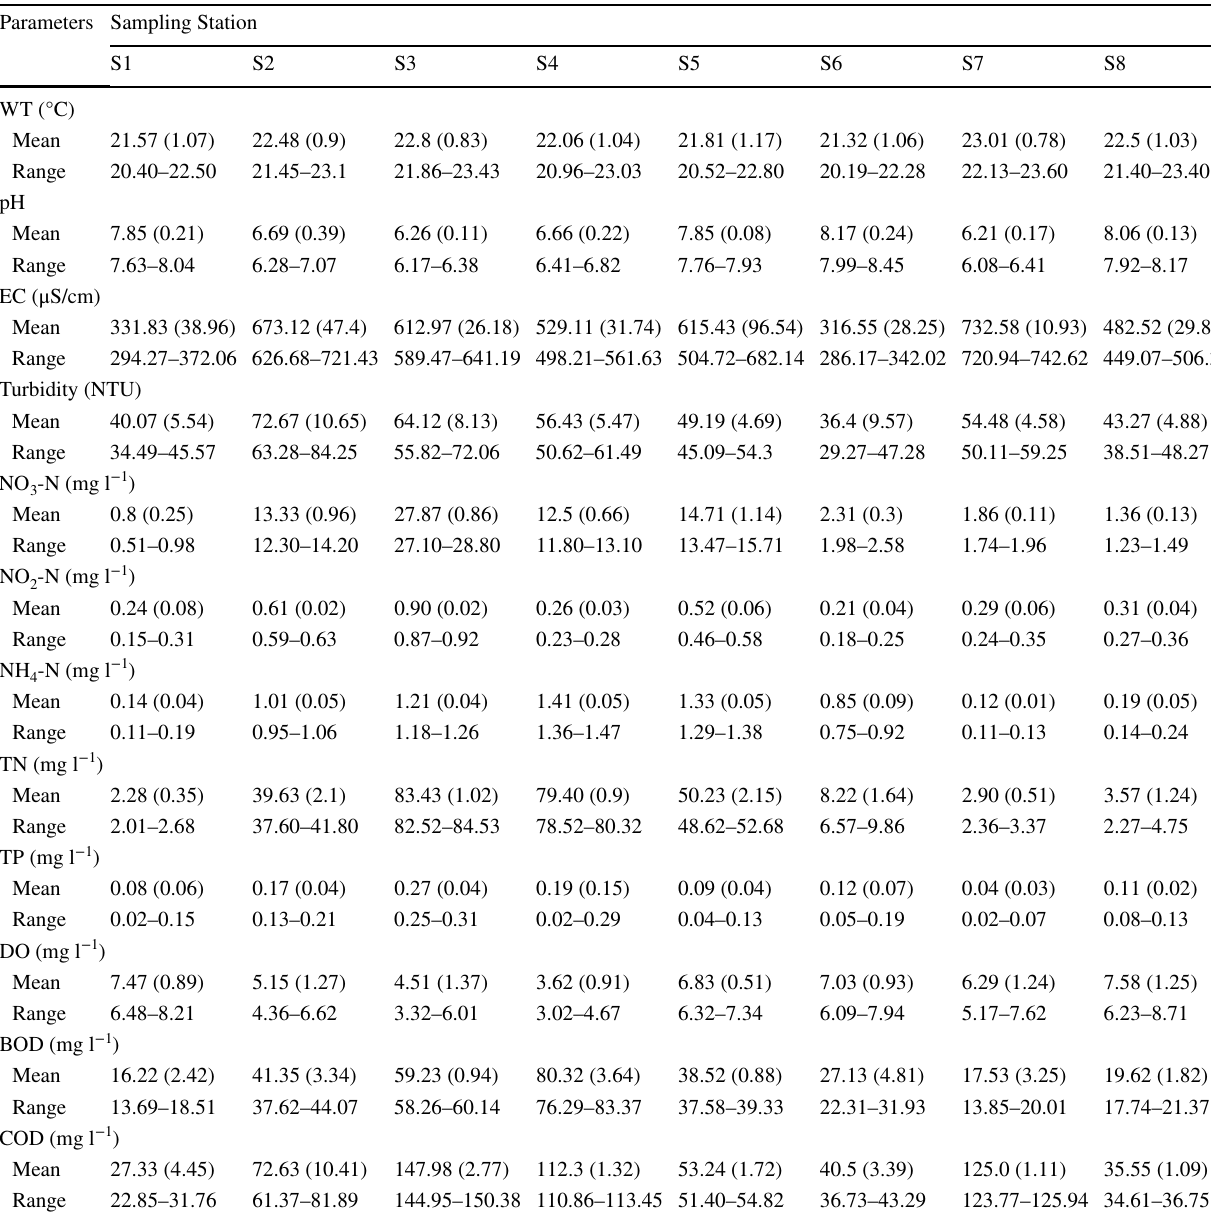
Table 1 Physicochemical water quality parameters at different locations of the Awash River during dry season